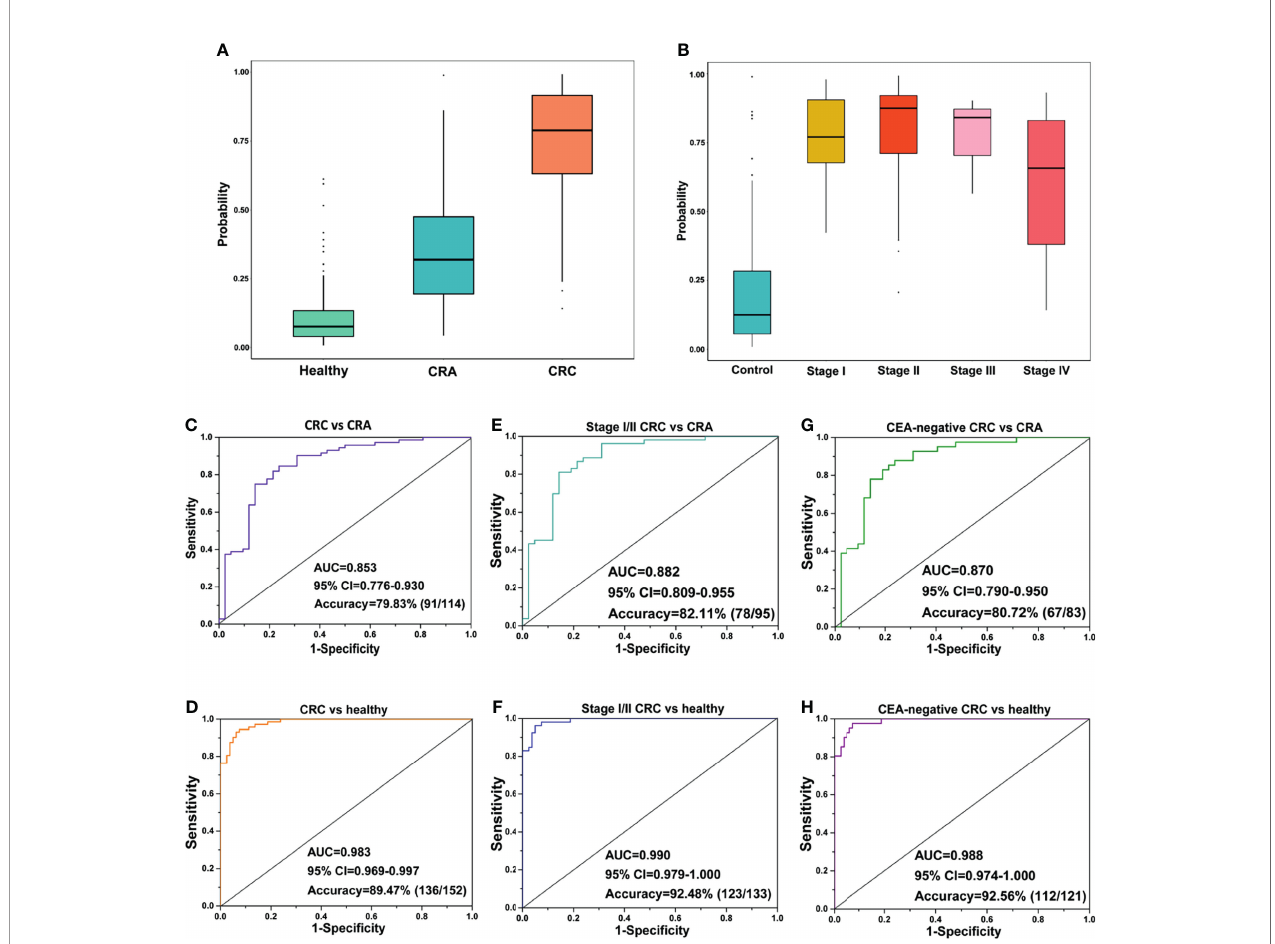
FIGURE 3 | Prediction performance of the exLR d-signature in subgroups. (A) The d-signature in distinguishing healthy, CRA, and CRC individuals. (B) The d- signature in control and stage I – IV CRC participants. The ROC curve for the d-signature in CRC and CRA (C) , CRC and healthy (D) , early-stage (stage I – II) CRC and CRA (E) , early-stage (stage I – II) CRC and healthy (F) , CEA-negative CRC and CRA (G) , and CEA-negative CRC and healthy (H) cohorts.